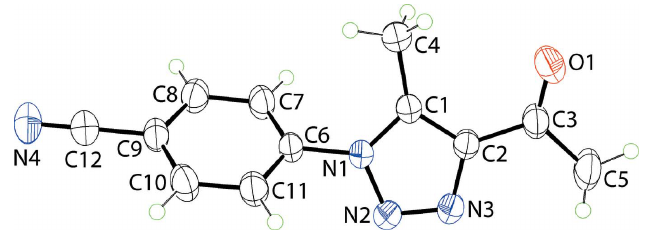
Figure 2 A view of the unit-cell contents shown in projection down the b axis. The C O (cid:3)(cid:3)(cid:3) (cid:2) (triazoyl), C N (cid:3)(cid:3)(cid:3) (cid:2) (triazoyl) and (cid:2) (tolyl)– (cid:2) (tolyl) contacts are shown as orange, blue and purple dashed lines, respectively.